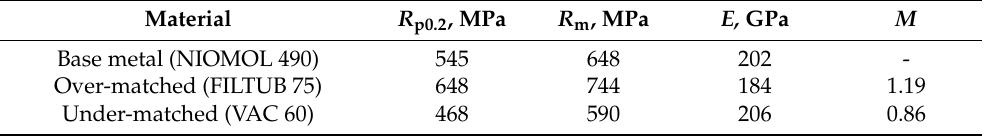
Table 1. Mechanical properties of base and weld metals with mismatch factor.